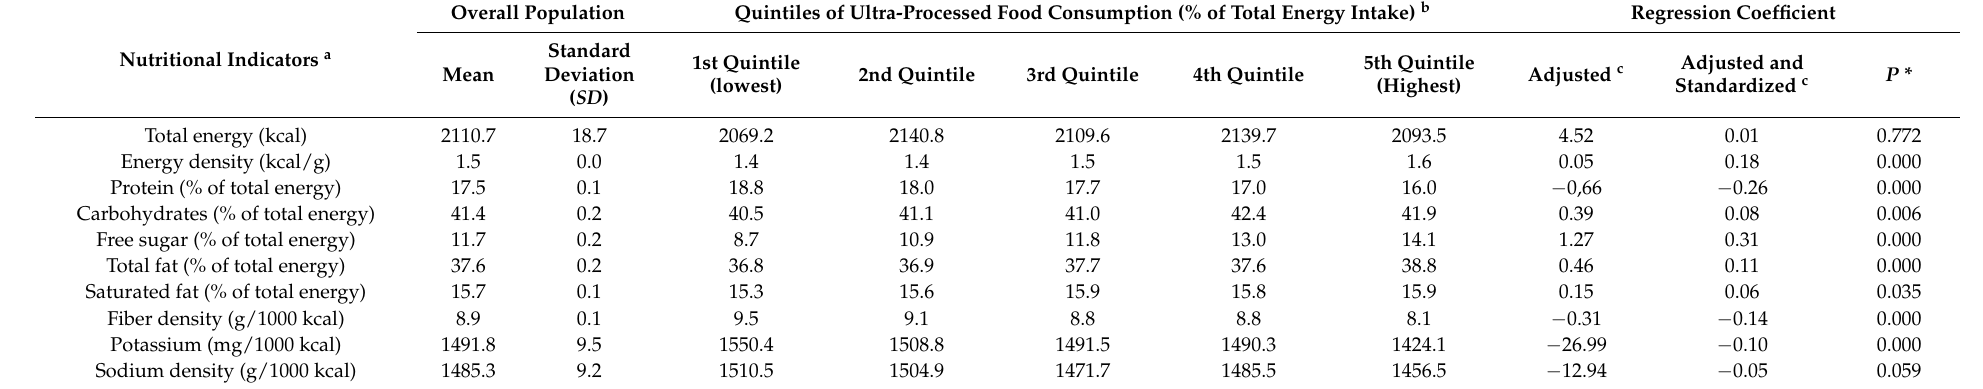
Table 5. Nutrient intake indicators of the overall population and according to quintiles of ultra-processed food consumption. French population aged ≥ 18 years old. ENNS 2006 ( n = 2642). Overall Population Regression Coefficient Nutritional Indicators a